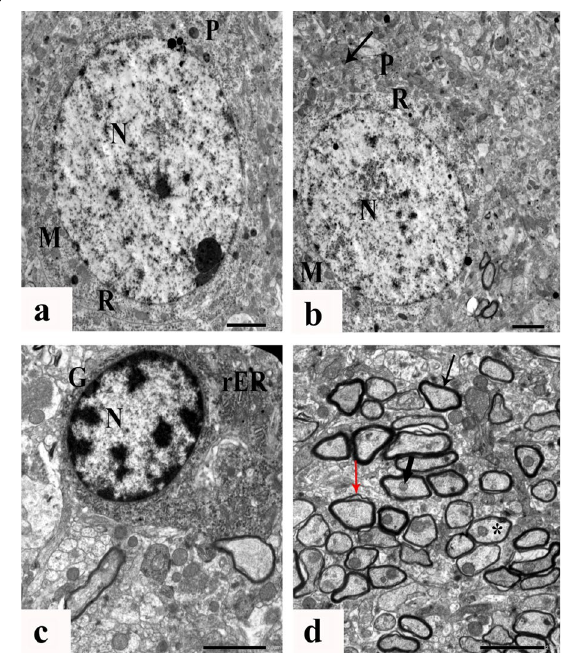
Fig.9 Electron micrographs of the cerebral cortex obtained from treated-paroxetine rats with showing a : degenerated granule cell with dense nucleus (N), and degenerated mitochondria (M). b : a degenerated pyramidal cells (P) with irregular or shrunk nuclei (N), and degenerated cytoplasm (*) contained distorted mitochondria (M). c : apoptotic pyramidal cell (P) with abnormal nucleus (N), severe intended nuclear envelop (thin arrow) and some apoptotic blebs (thick arrow). d : myelinated nerve with irregular outline of its axons, splitting or discontinuity myelin sheath (arrows), and rarified axoplasm (*)